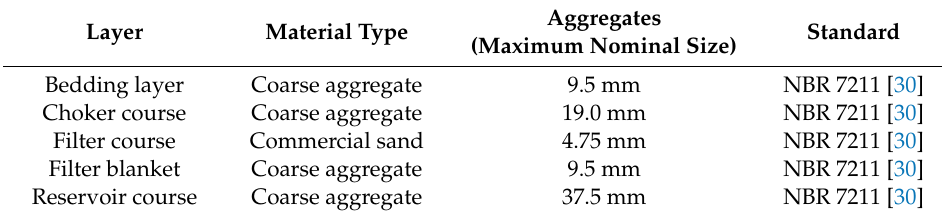
Table 2. Maximum nominal size of the materials used in each layer of the model